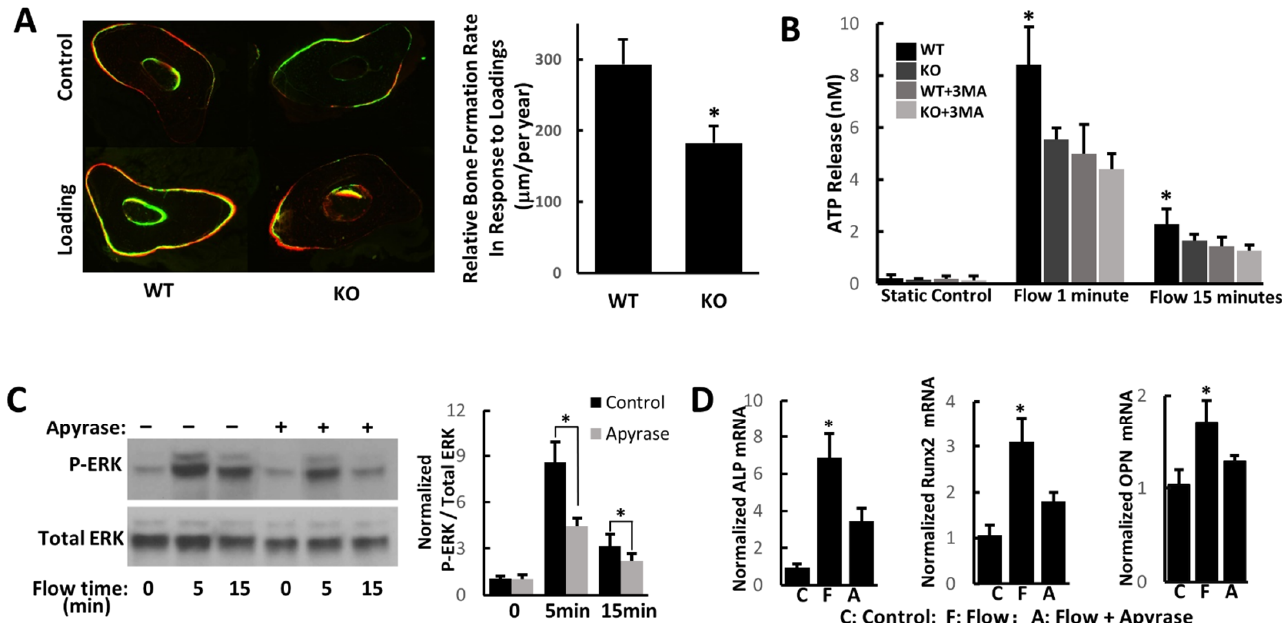
Figure 3. Autophagy is involved in osteoblast mechanotransduction. ( A ) Relative bone formation rates at the ulnar midshaft (loaded side minus unloaded side), which were induced by external mechanical loading, were significantly decreased in autophagy-deficient mice compared to wild-type mice. ( B ) ATP release of WT and Atg7 KO osteoblasts in response to oscillatory fluid flow with and without 3 MA. ( C ) ERK1/2 phosphorylation in response to oscillatory fluid flow with and without apyrase. (D) Osteoblast gene expression of ALP, Runx2, and osteopontin with and without apyrase. ( n = 5, * p < 0.05; each bar represents the mean ± SEM).